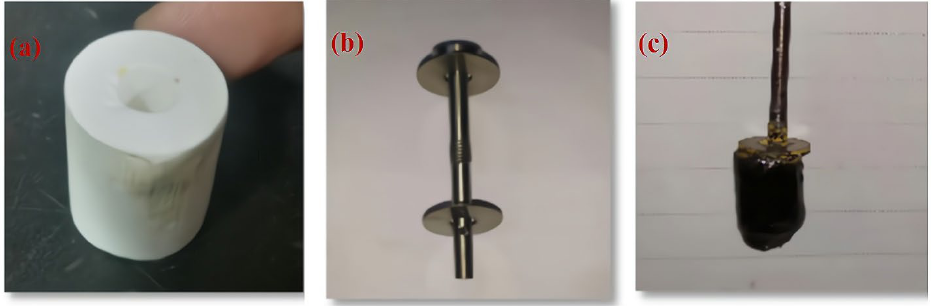
Figure 1. Preparation of the lime column. ( a ) Lime column after roasting; ( b ) molybdenum rotor; ( c ) lime column at the end of the experiment. The slag used in this study was synthesized from analytical reagents. In the ex- periment, Na 2 O and P 2 O 5 were replaced with anhydrous sodium silicate and calcium phosphate, respectively. All the experimental chemical compositions are listed in Table 1.